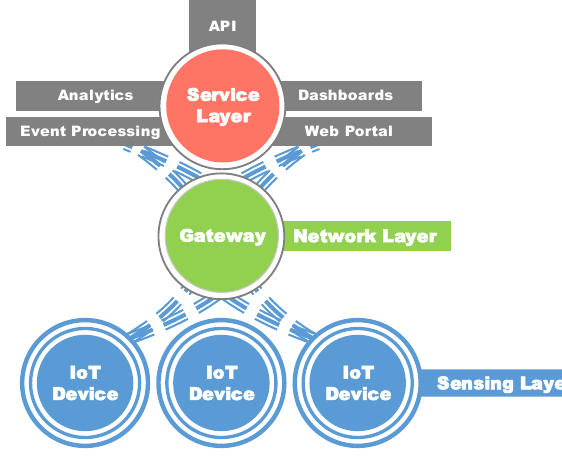
Figure 2. The reference three-layer architecture for IoT-based water